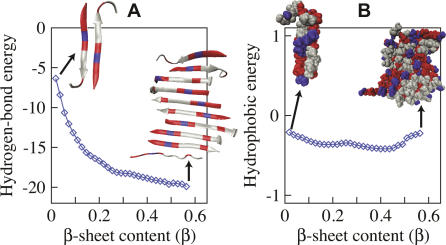
One-Step Ordering of Aβ25–35 OligomersCompetition between hydrophobicity and hydrogen bonding in the ordering process of the oligomers formed by the Aβ25–35 peptide. As in Figure 4, we report the average interchain hydrogen-bond energy per chain (A), and the average interchain hydrophobic energy with respect to the order parameter β (B). Two representative oligomer configurations are shown corresponding to β = 0 and β = 0.58. As opposed to the case of the Aβ16–22 peptide shown in Figure 4, however, there is no evidence of structural reorganization within the oligomers, and therefore even small oligomers are ordered, provided that the overall degree of order in the ensemble, β, is very small due to the large fraction of unstructured monomers present in the system.